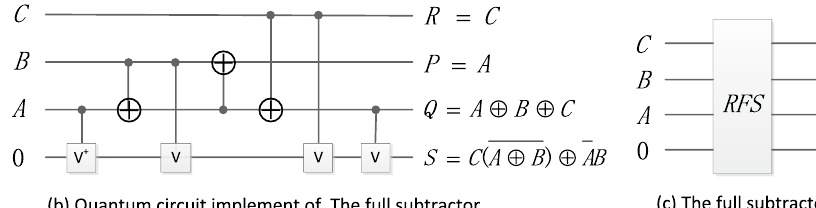
Figure 16. The RFS and its quantum